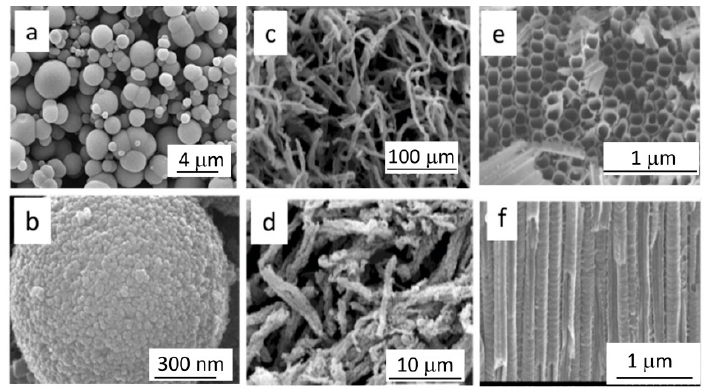
Figure 3. SEM images of examples of DSSCs PAs based on different TiO 2 nanostructures. ( a , b ) adapted with permission from [43]. Copyright 2008, Wiley & Sons; ( c , d ) adapted with permission from Ref. [48], Copyright 2010, American Chemical Society; ( e , f ) adapted with permission from Ref. [53], Copyright 2010, American Chemical Society.